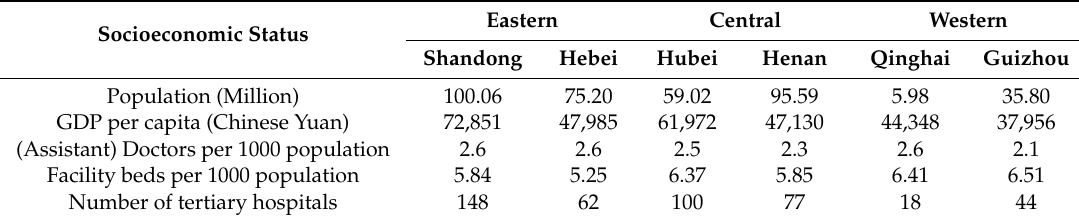
Table 1. Socioeconomic status of sampled